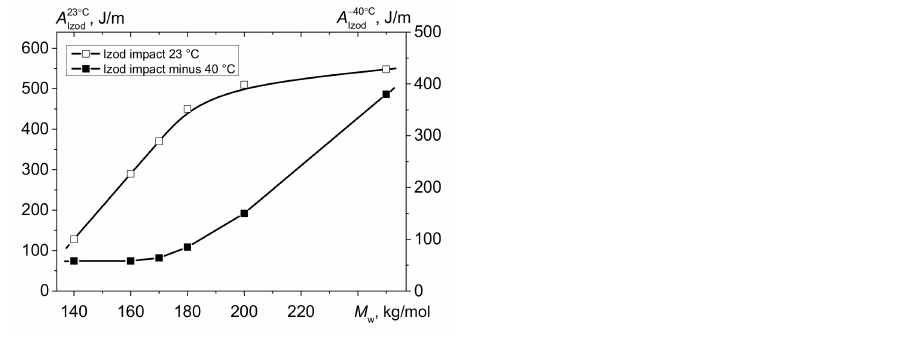
Figure 3. Izod impact strength at test temperatures of +23 ◦ C (A Izod+23 ) and − 45 ◦ C (A Izod − 40 ) as a function of M w for the bimodal HDPE